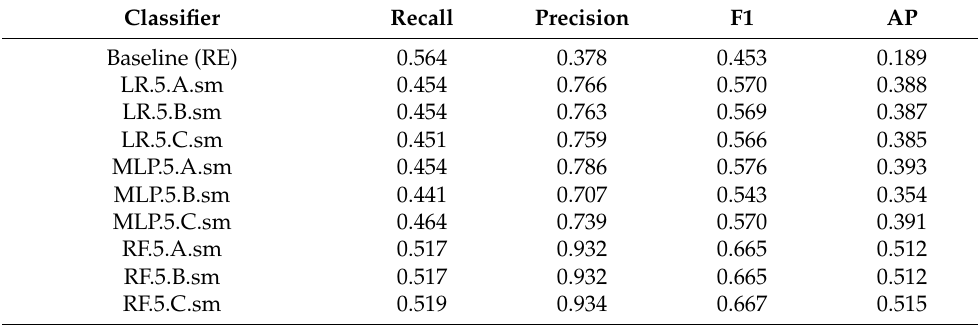
Table 5. Classifier performance for 5.sm dataset and different model positions in the pipeline.